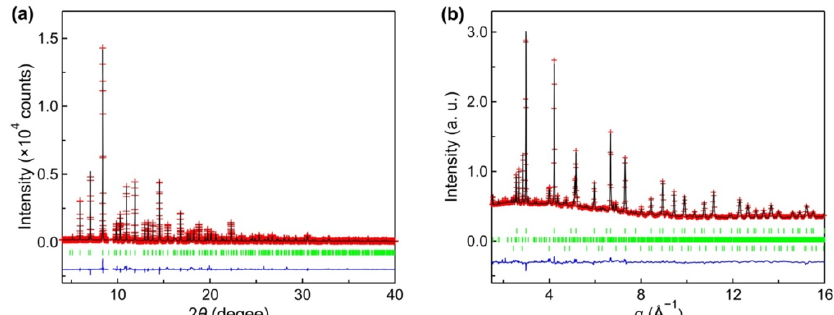
Figure 5. Rietveld analysis against ( a ) SXRD and ( b ) ND pattern of S-2-2 synthesized by Mg reduction twice at 1000 °C for 10 h and hydrogenated with CaH 2 at 520 °C for 120 h with λ = 0.420526(1) Å (SXRD). The red crosses, black line, blue line, and green dashes denote, respectively, the observed, calculated, difference intensities, and Bragg positions.